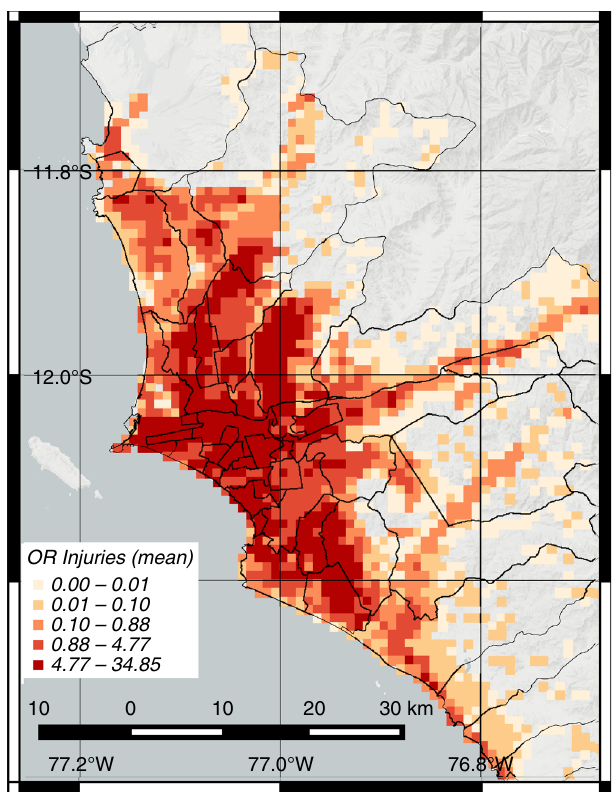
Fig. 1 Earthquake scenario representing the M 8.0 1940 earthquake in Lima. The earthquake occurred in the subduction fault in the coast of Lima and caused widespread damage to the city 22,70 . The estimated area of fault rupture is shown in red. The edge dimensions were estimated with empirical formulas 63 . The fault plane dips 15 ∘ , where the edge underneath the coast is deeper than the edge under the ocean. The median peak ground acceleration (PGA) is also estimated with empirical formulas 64 . The shaking attenuates for regions further away from the rupture in the fault plane. Lima city and its districts are delimited by the black shapes. Source data are provided as a Source Data fi le, and the base map layer is available under a https://www.openstreetmap.org/copyright Open Database Licence (© OpenStreetMap